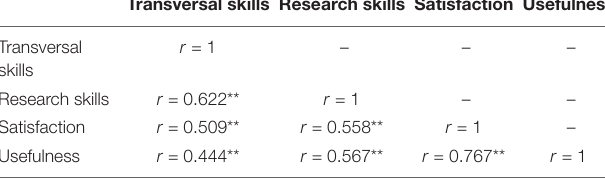
TABLE 4 | Pearson correlation analysis between the student perceptions about the acquisition of transversal skills and research skills, and their evaluation of satisfaction and usefulness, for the PBL-courses ( n = 277